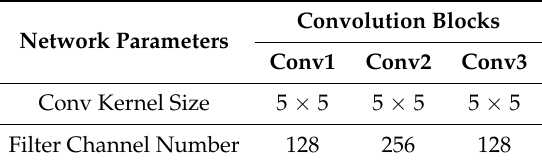
Table 1. Parameter configuration of